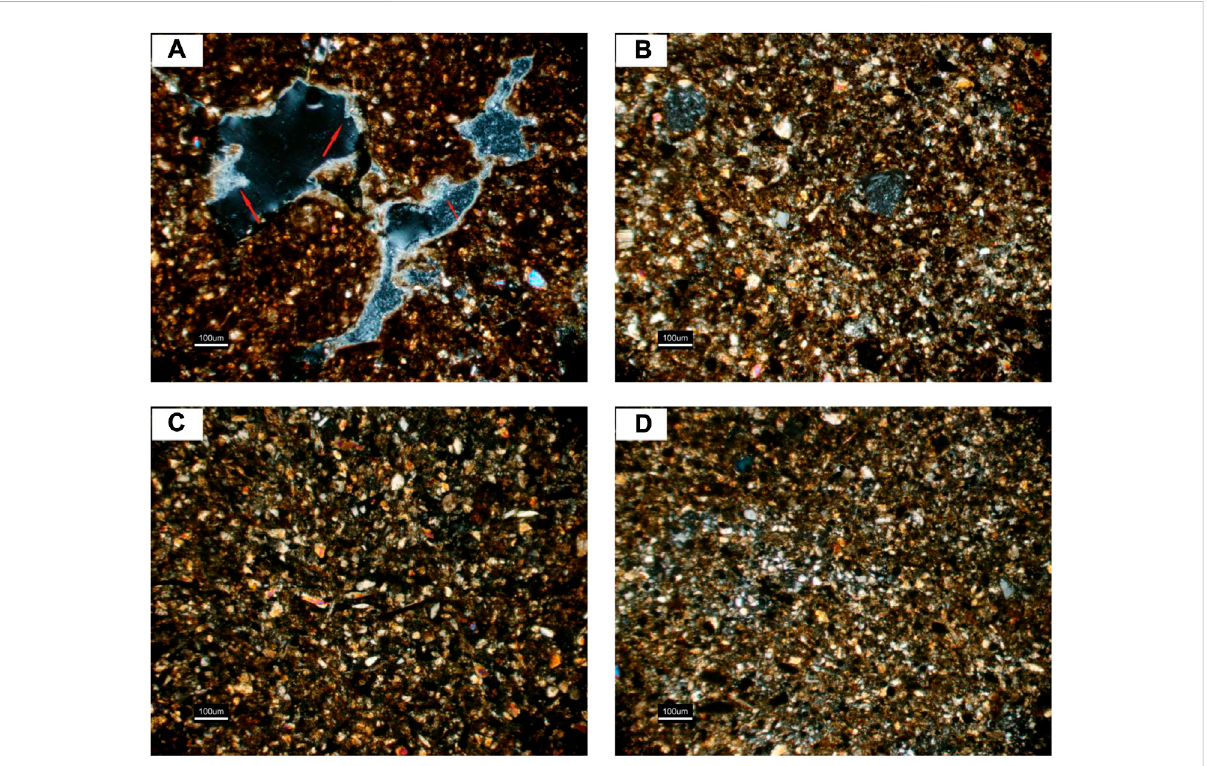
FIGURE 9 Micro-morphologicalfeaturesintheZHKandCMQpro fi lesintheYellowRiversourceareaontheNETibetanPlateau. (A) Micro-morphological featuresofthepaleosolintheCMQpro fi lewithneedle-shapedsecondary-calcite(10×5,crossedpolarizedlight); (B) Micro-morphologicalfeatures oftheaeolianloess inthe ZHKpro fi le (10× 5, crossed polarized light); (C) Micro-morphological features ofthe overbank fl ooding deposits (OFD1) in the CMQ pro fi le (10 × 5, crossed polarizedlight); (D) Micro-morphological features of the overbank fl ooding deposits (OFD1)in the ZHK pro fi le (10 × 5, crossed polarized